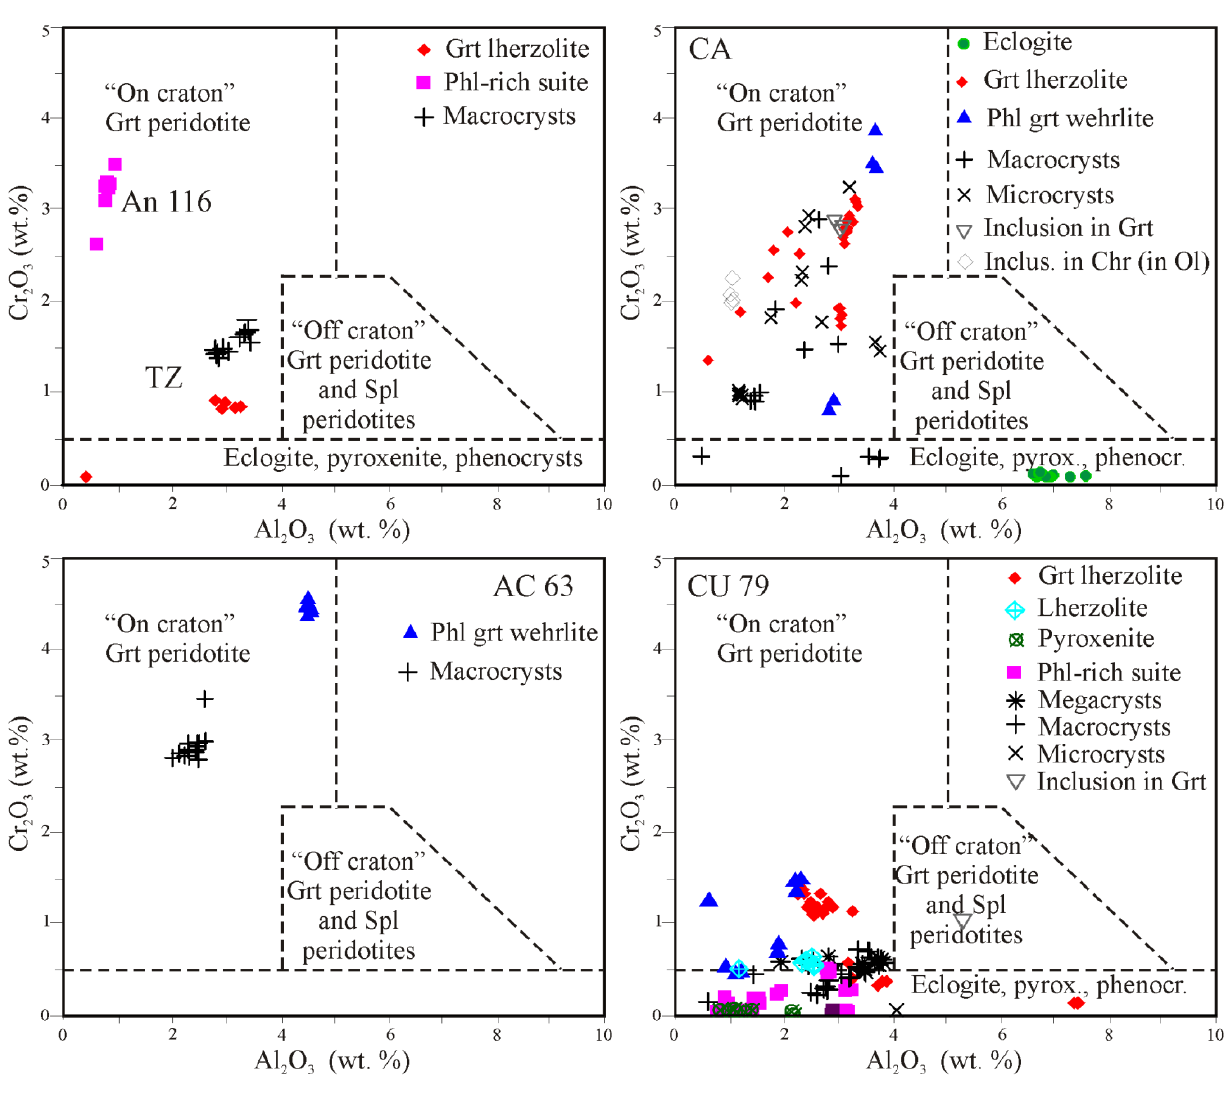
Figure 6. Cr O vs. Al O diagram for clinopyroxene from the ( a ) An116, TZ; ( b ) CA; 2 3 2 3 ( c ) AC63; ( d ) CU79 kimberlites. Classification diagram after Ramsey